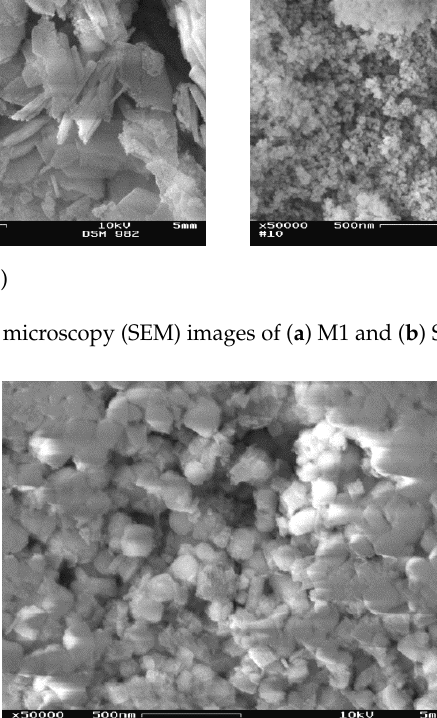
Figure 4. SEM image of M1/SiO 2 90:10 at 50,000× magnification. Catalysts 2020 , 10 , x FOR PEER REVIEW